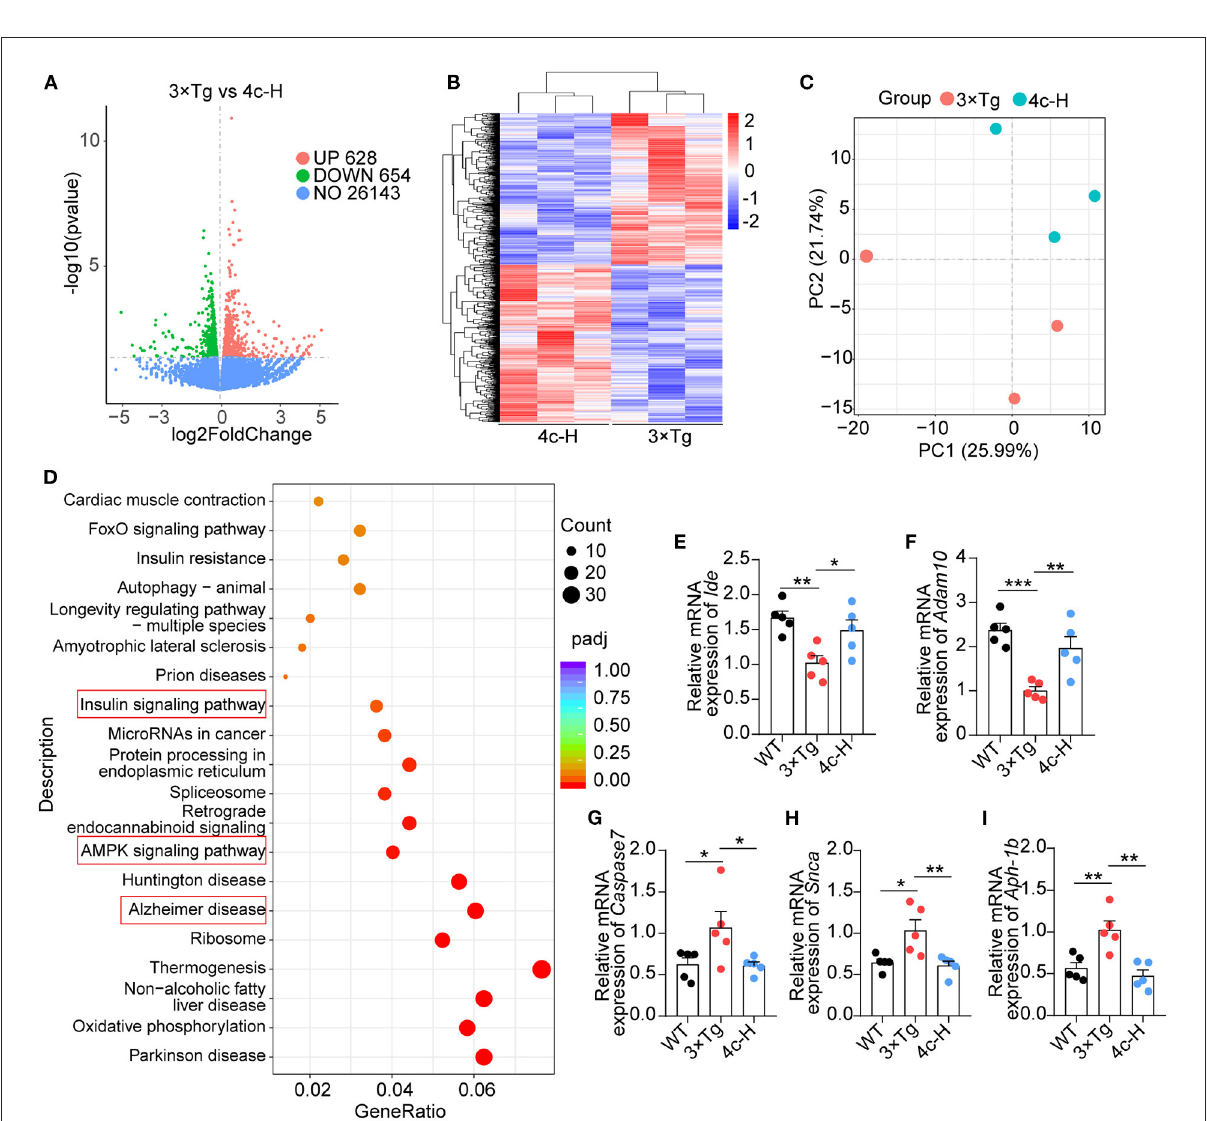
FIGURE7 Transcriptome analysis of hippocampal tissues. Hippocampal tissues from 3 x Tg AD mice treated without or with 4c (i.e., 3 x Tg and 4c-H groups) were selected for transcriptome analysis. (A) Volcano plots of DEGs between the 3 x Tg and 4c-H groups. DEGs were identified by comparing 3 x Tg and 4c-H mice using fold change > 1 and P -value < 0.05 as the cut-off ( n = 3). (B, C) Hierarchical clustering and PCA analysis of the 3 x Tg and 4c-H groups were performed using the normalized RNA-seq read counts. (D) KEGG pathways enriched in the 628 and